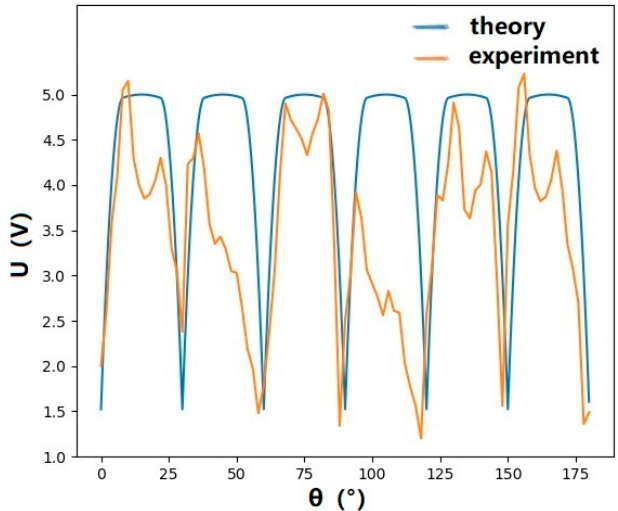
Figure 7. Relationship between the output voltage of the combined optical system and the departure angle.